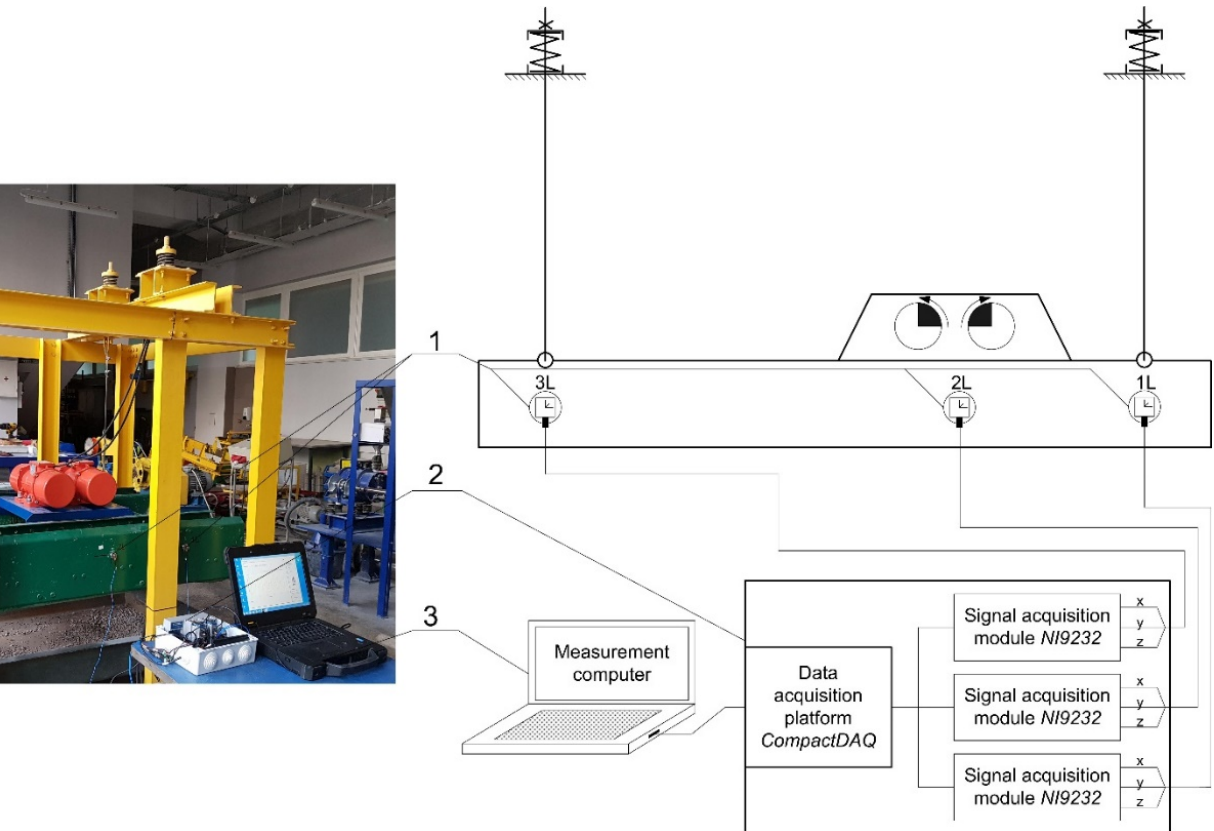
Figure 7. Stand after the modernization of the drive system—during the measurement of vibrations: 1—acceleration sensors; 2—measurement cards; 3—measurement computer.